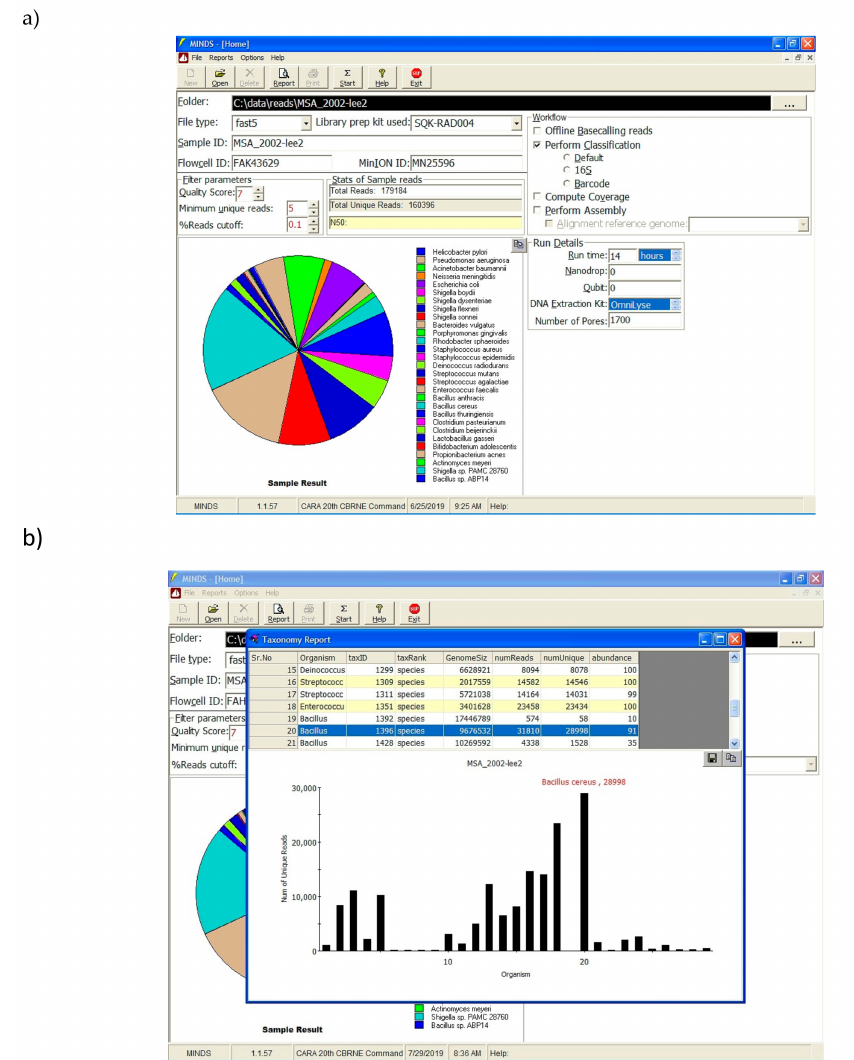
Figure 3. ( a ) MINDS graphical interface allows users to straightforwardly submit the FASTQ file, input experimental metadata and conditions, generates intuitive data analysis and ( b ) easily interpretable